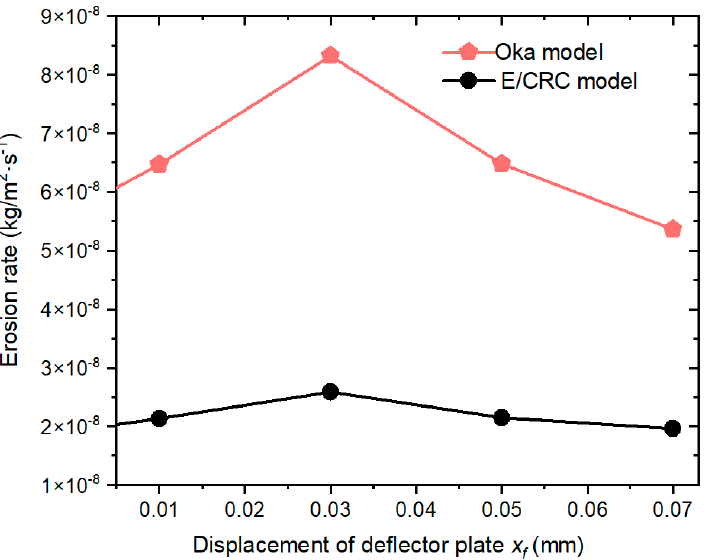
Figure 12. Erosion area with different deflector displacement. Subfigure ( a – e ) represents the erosion area of receiving shunt wedge, when the deflection displacement is 0.00 mm, 0.01 mm, 0.03 mm, 0.05 mm and 0.07 mm respectively.